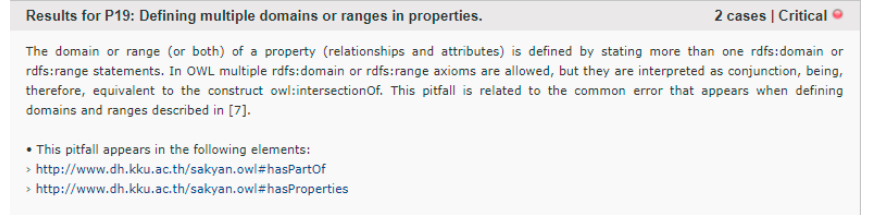
Figure 7. An excerpt from the critical pitfall.